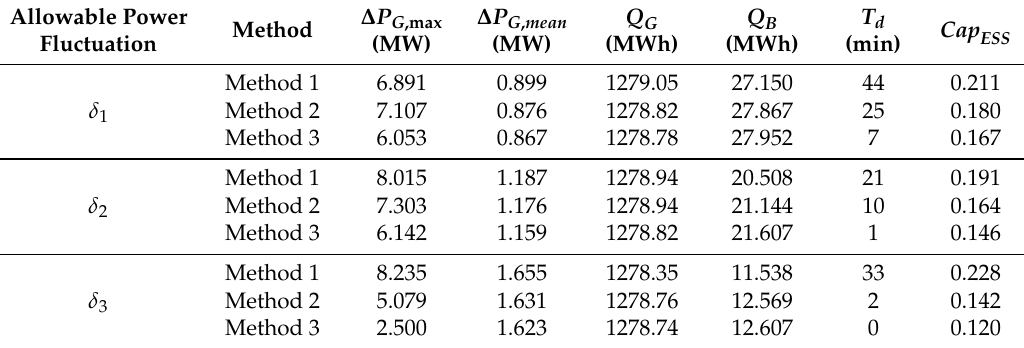
Table 5. Assessment criteria under different δ